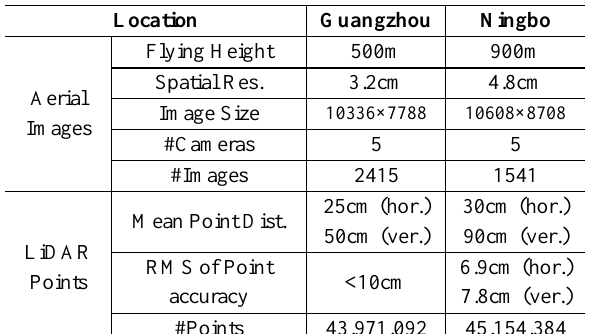
Table 2. In Ningbo dataset, 28 L-junctions were manually collected and automatically